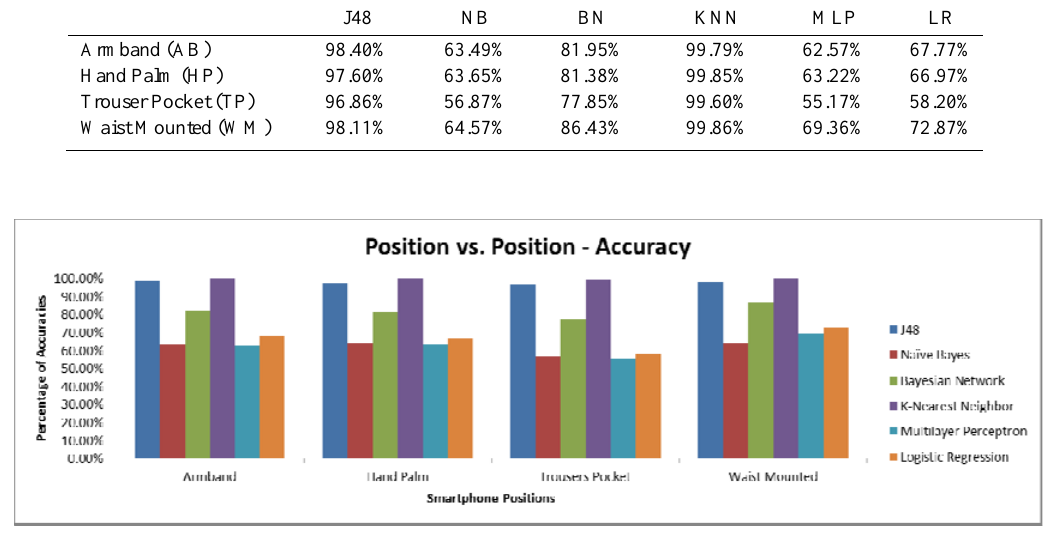
Fig. 4. Position vs. position comparison in terms of accuracy